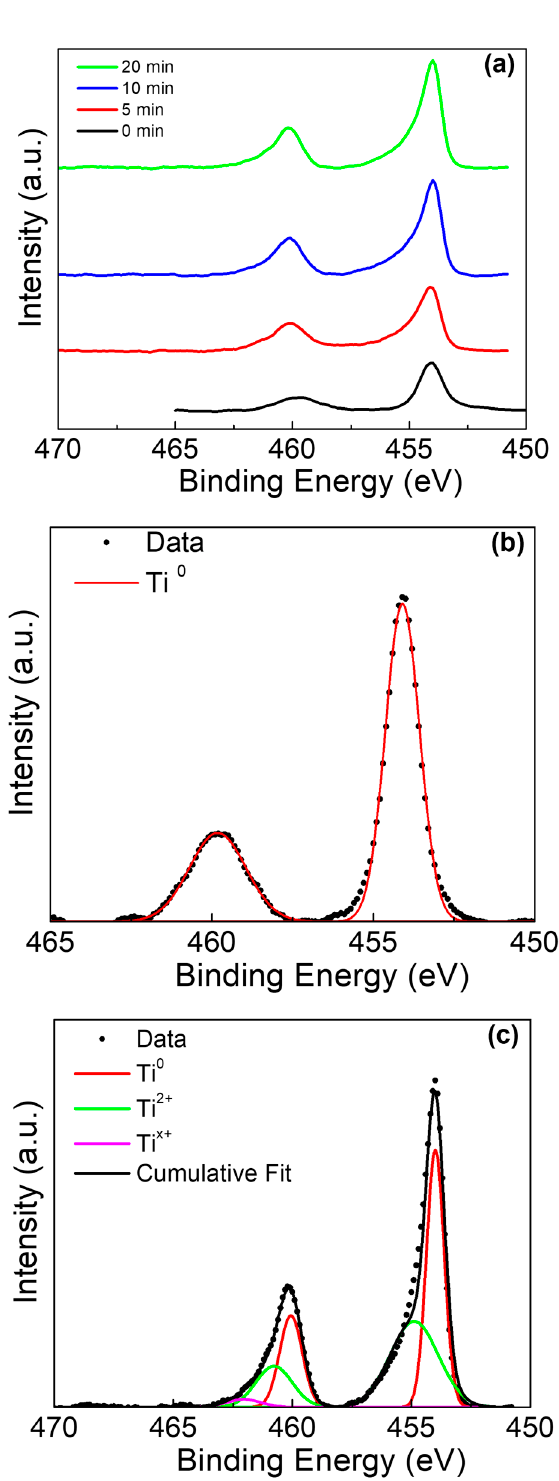
Figure 4. Ti 2p XPS of Ti rod without amalgam in pH 2. ( a ) Ti 2p peak at various sputter times, ( b ) deconvolution of 0 min sputter time, and ( c ) deconvolution of 20 min sputter time.